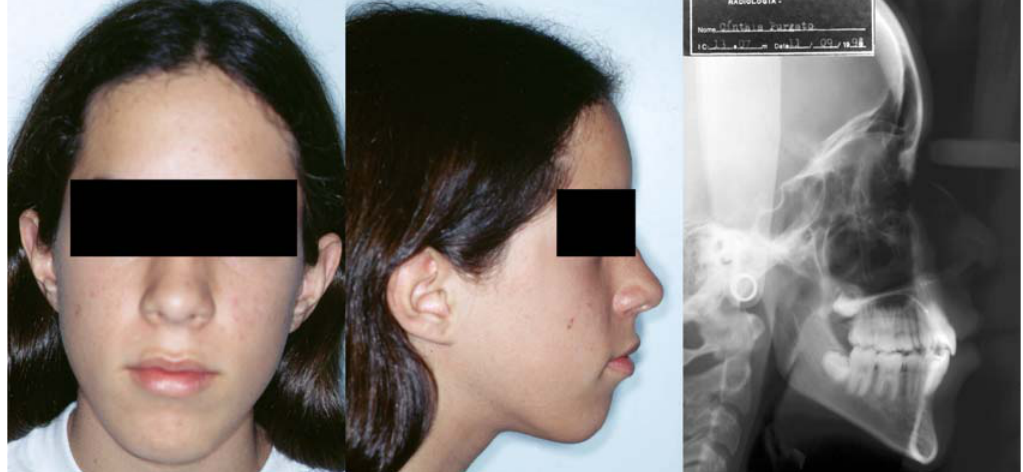
FIGURE 5 - Frontal and lateral facial views and cephalometric lateral radiograph at the end of treatment (13 years and 7 months old)